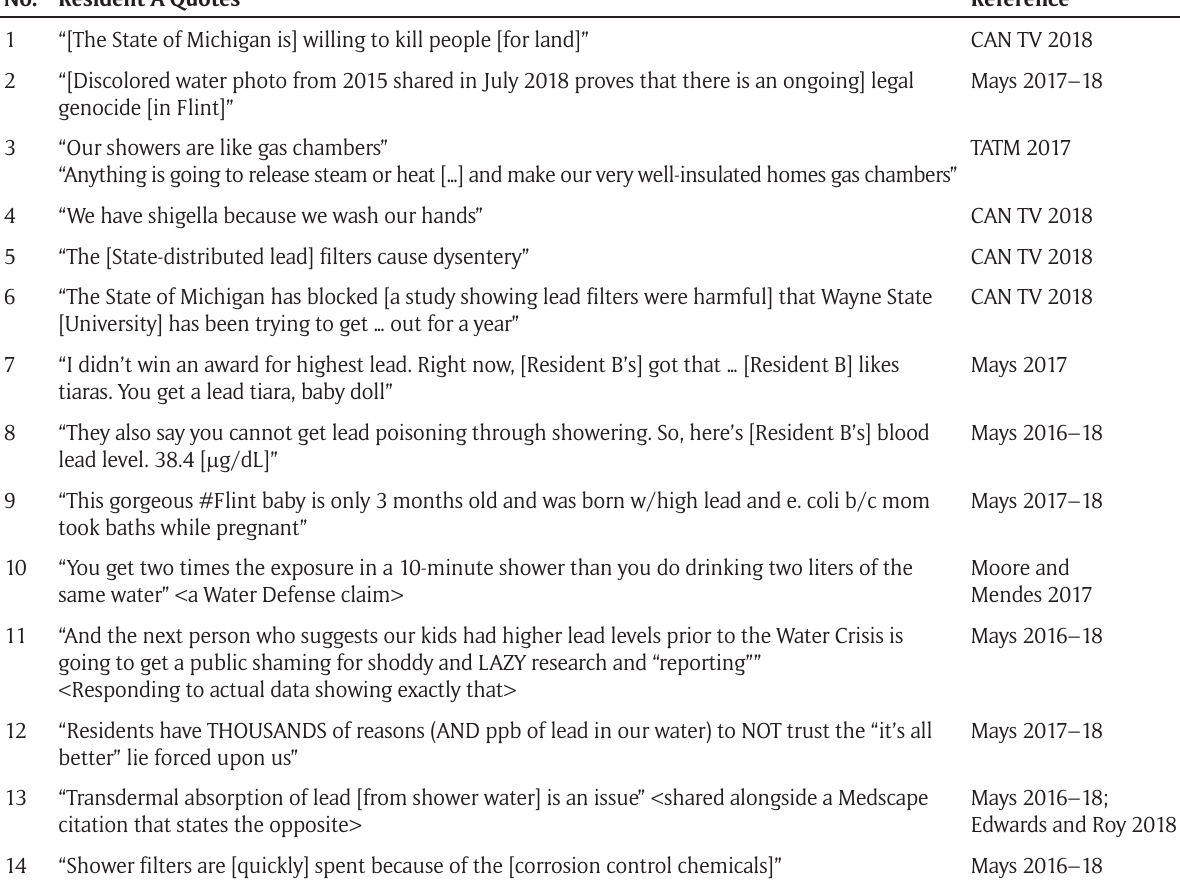
Table 1: Illustrative scientific claims by Flint Resident